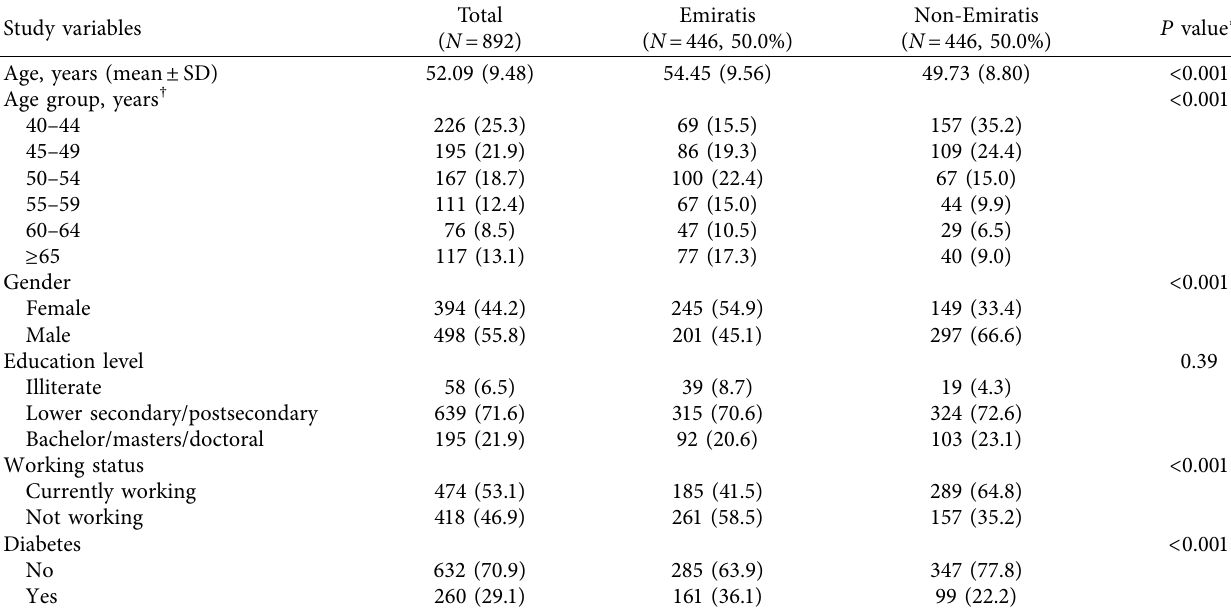
Figure 1: Comparison of age-sex structure of Emirati sampled participants and the general population of Emiratis in Dubai Table 1: Characteristics of examined study participants.